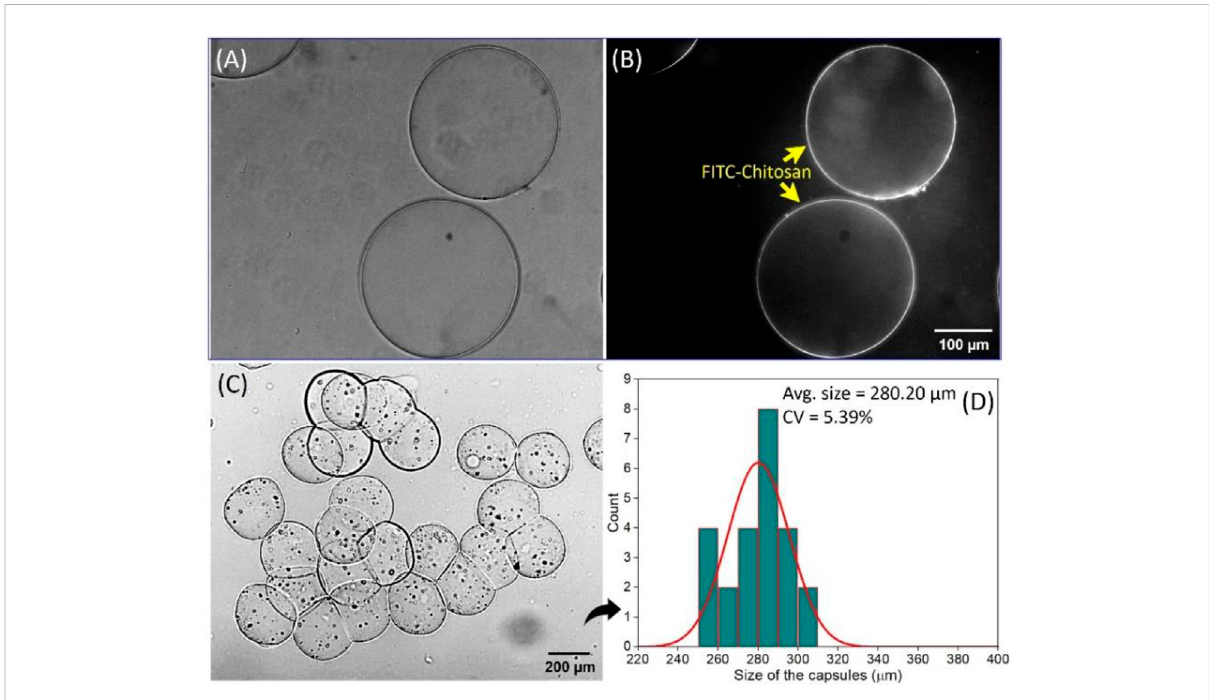
FIGURE 6 Con fi rmation (A) Bright- fi eld image, (B) fl uorescence image of the hydrogel capsules con fi rming the interfacial complexation between SA and FITC-chitosan. The encapsulation of magnetic particles, Fe 2 O 3 nanoparticles, (C) optical microscope image of the hydrogel capsules encapsulating Fe 2 O 3 nanoparticles, and (D) histogram of the size distribution of Fe 2 O 3 nanoparticles encapsulated hydrogel capsules with small